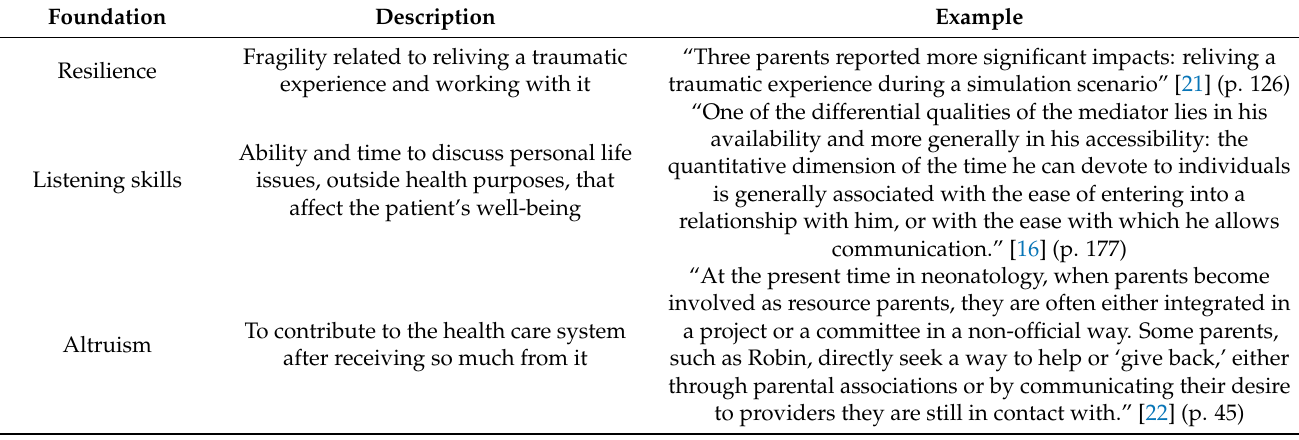
Table 2. Personal ethical foundations of accompanying patients.